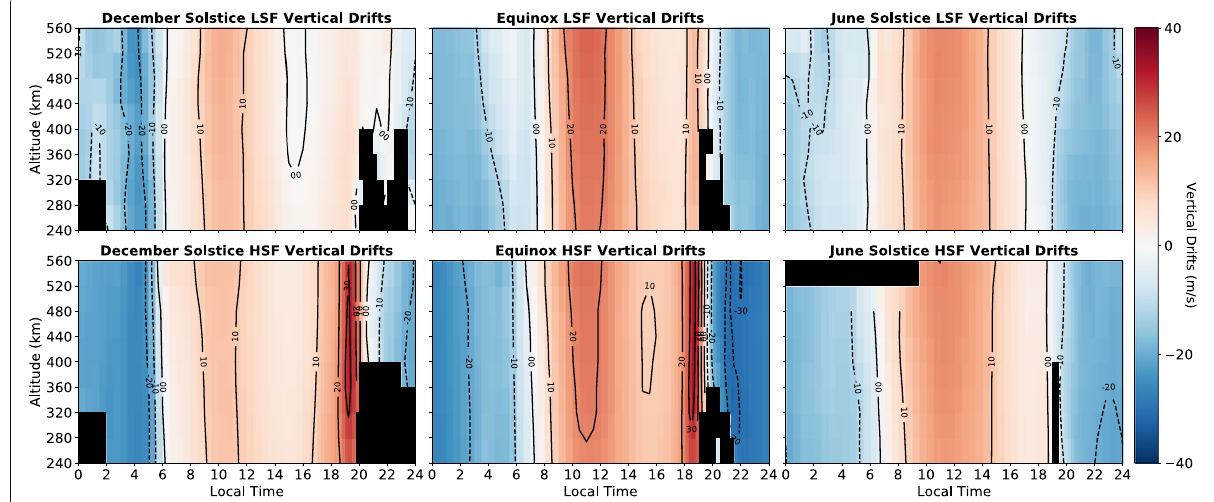
Fig. 1 Vertical drifts estimated from the Jicamarca incoherent scatter radar measurements for different seasons (columns) and solar flux conditions (rows). These vertical drifts are used as inputs to the analytic model of the zonal